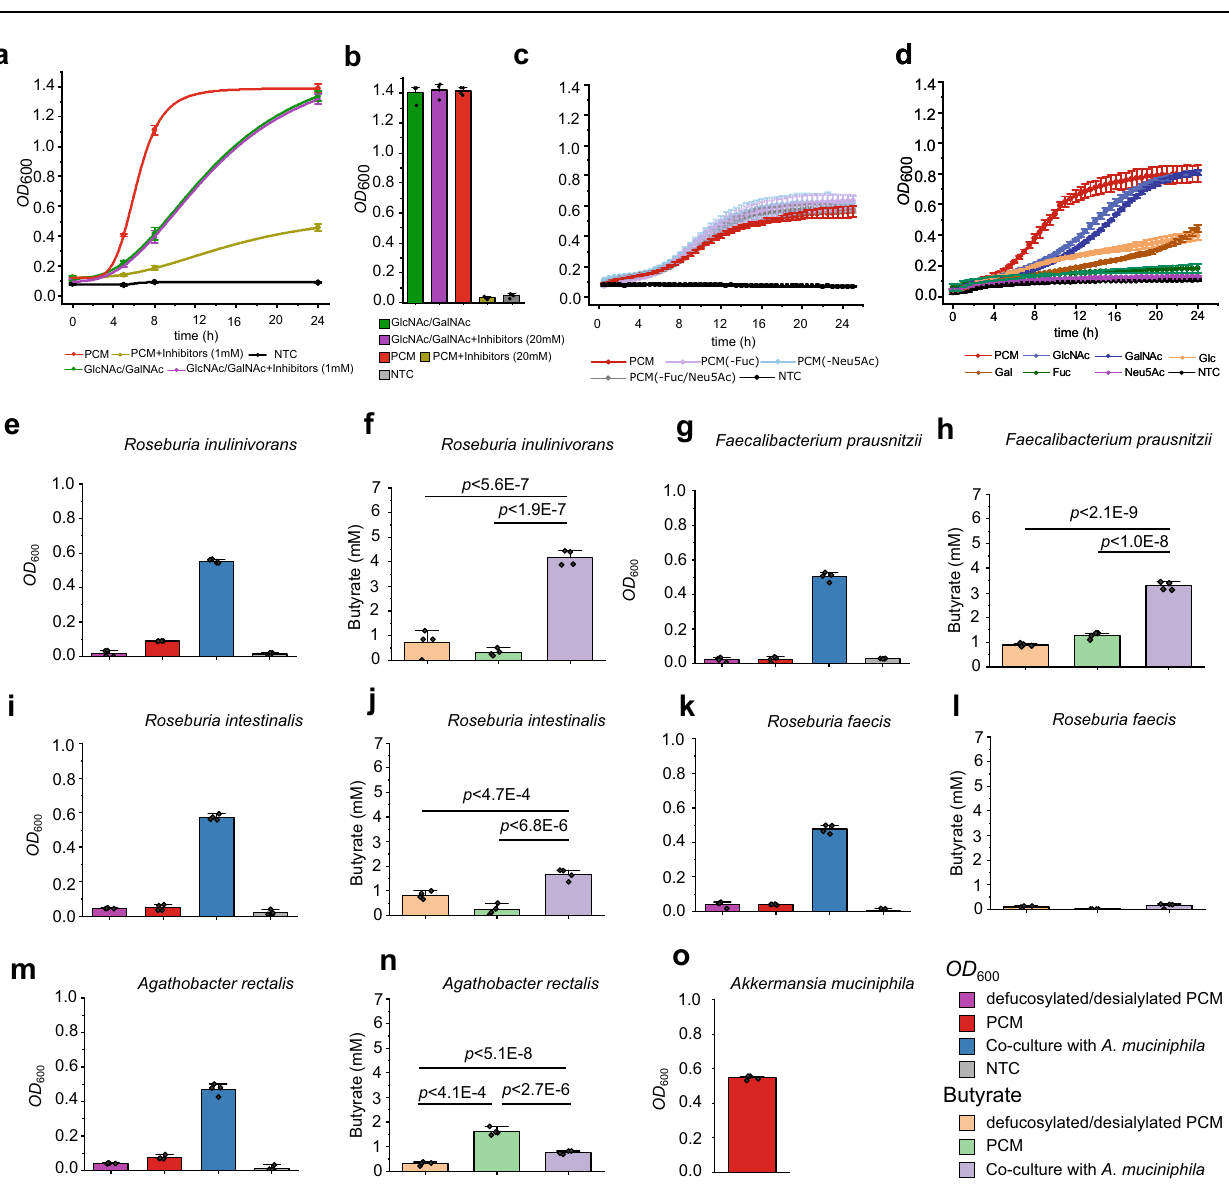
Lachnospiraceae families in microtitre plates on PCM and de-fucosylated/de-sia- lylated PCM (including a no-carbon source control) in monocultures or in co- culture with A. muciniphila on PCM after 24h. f , h , j , l , and n . The corresponding butyrateconcentrationsinculturesupernatants. o Growthlevelof A.muciniphila in monocultureonPCMafter24h.Growthanalyses( a – d , e , g , i , k , m and o )onmedia supplemented with 0.5% (w/v) mucin or a 1:1 mix of GlcNAc and GalNAc were performed in four independent biologicalreplicates( n =4) and butyrate inculture supernatants was analyzed from 3 independent growth experiments ( n =3). The growthdataandbutyratequanti fi cationsaremeanvalueswithstandarddeviations (SD) as error bars. The statistical signi fi cance between butyrate concentrations reached was evaluated using an unpaired two-tailed Student ’ s t -test and the cor- responding p -valuesareincludedinthe fi gurepanels.Sourcedataareprovidedasa Source Data fi